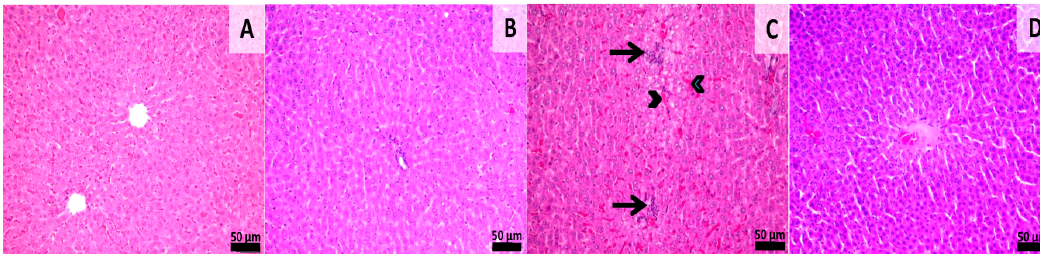
Figure 6. Histology of liver sections. Group 1 ( A ) shows normal hepatic morphology. Group 2 ( B ), normal morphology, Group 3 ( C ), Congestion of the sinusoids (arrowheads) in the mandibular and central areas, and mononuclear inflammatory infiltrate near the central veins and portal spaces (arrows). Group 4 ( D ), Normal hepatic morphology. HE stain, Scale bar = 50 μm.